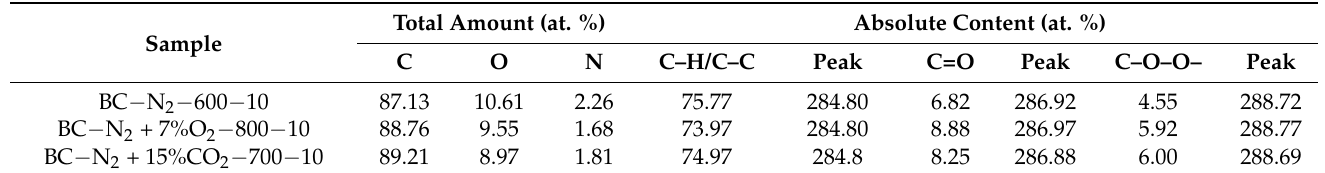
Table 4. The content of elements and carbon-containing functional groups on the surface of the typical BC samples [41]. Reprinted/adapted with permission from Ref. [41]. 2022,